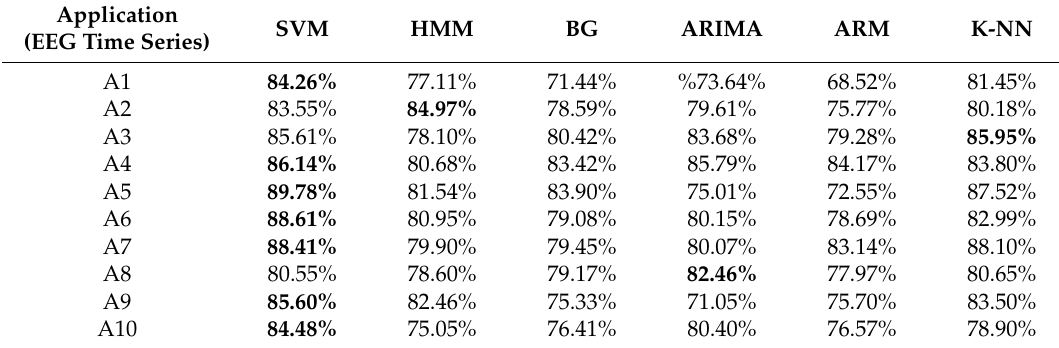
Table 12. Mean accuracy of different approaches for predicting the test data of each EEG time series (set